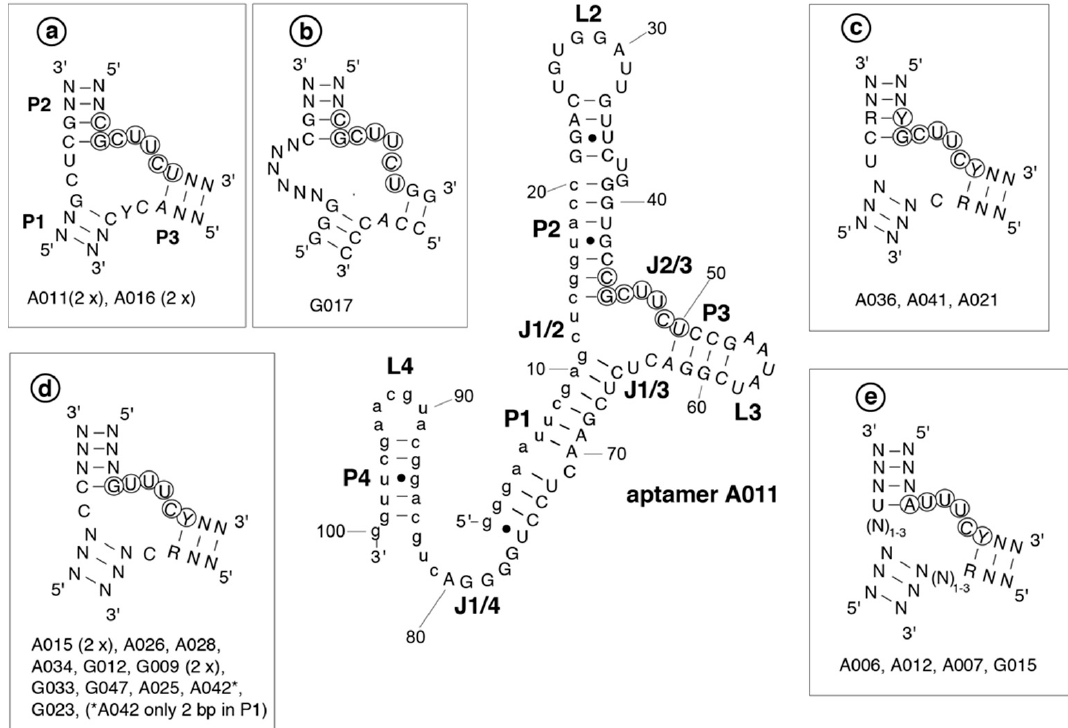
Figure 2. The secondary structure of mLBP-binding aptamer A011, as predicted by mfold (lowest free energy structure) or RNAfold (minimum free energy structure), is shown in the center. Nucleotides of the consensus motif are marked by circles, constant nucleotides of the primer binding sites by small letters. Helical elements were numbered as P1 to P4 (P = paired), loop regions L2 to L4, and joining segments according to the number of the helices they connect (e.g., J1/4). All other aptamers are predicted to adopt the same type of structure with a three helix junction in the core. Differences in the three helix junction were used to define lead structures of types a to e, with individual aptamer clones conforming to the respective subtype indicated below the corresponding structure. Group 1 aptamers constitute structures a to c, group 2 aptamers structures d and e.